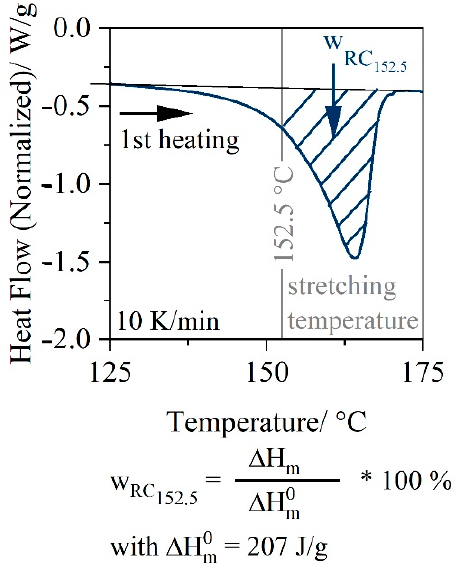
Figure 1. Definition of the residual crystallinity .